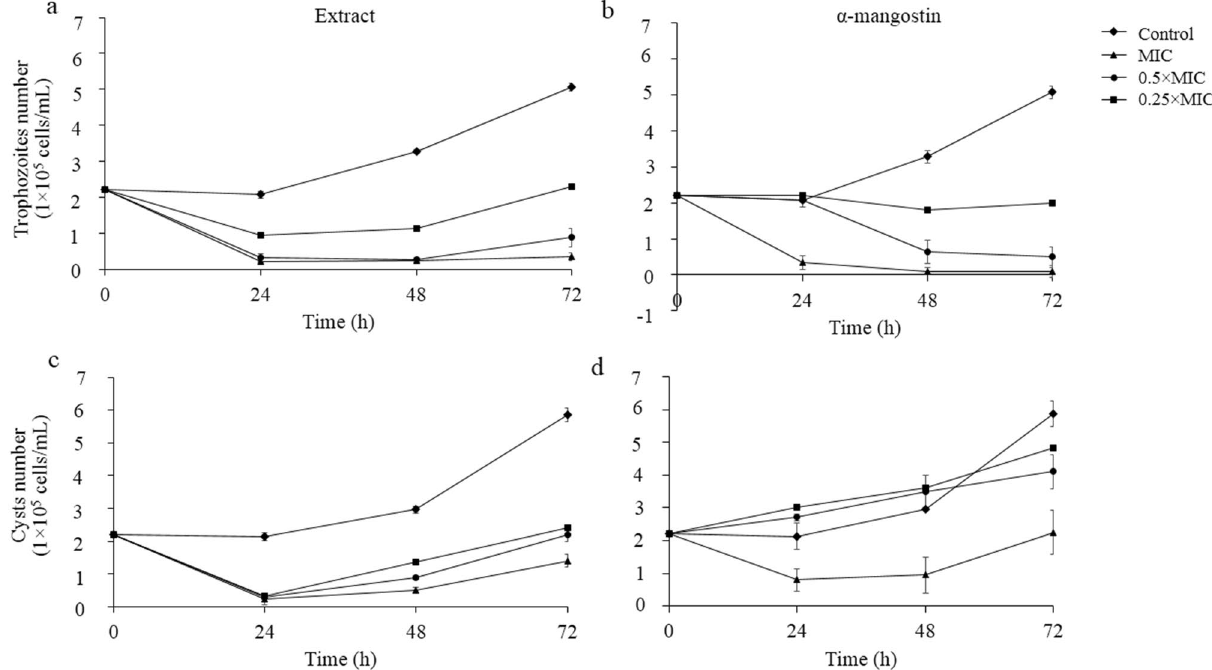
Figure 3. G. mangostana extract and α-mangostin inhibit the growth of A. triangularis trophozoites and cysts in vitro. To determine the effect of G. mangostana extract and α-mangostin on trophozoites ( a , b ) and on cysts ( c , d ), assays were performed by inoculating 2 × 10 5 cells/mL in PYG medium in the presence of G. mangostana extract or α-mangostin at MIC, 0.5 × MIC and 0.25 × MIC final concentrations. The inhibitory activity was carried out using trypan blue exclusion assay up to 72 h; 1% DMSO was used as a negative control.